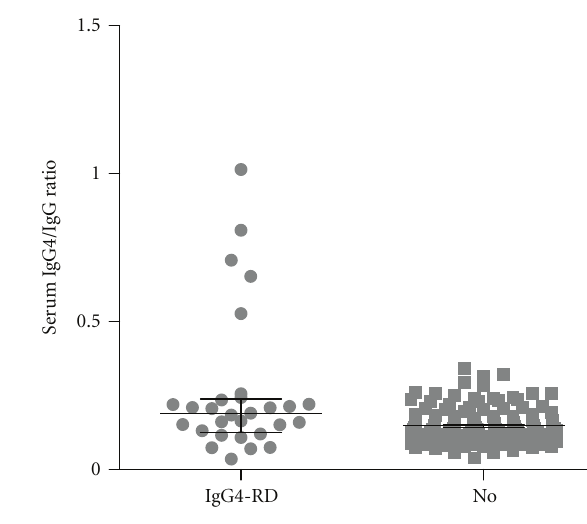
Figure 2: Serum IgG4/IgG ratios for IgG4-RD (definite and possible IgG4-RD) and non-IgG4-RD subgroups. Median and interquartile range (25% to 75%) are depicted.